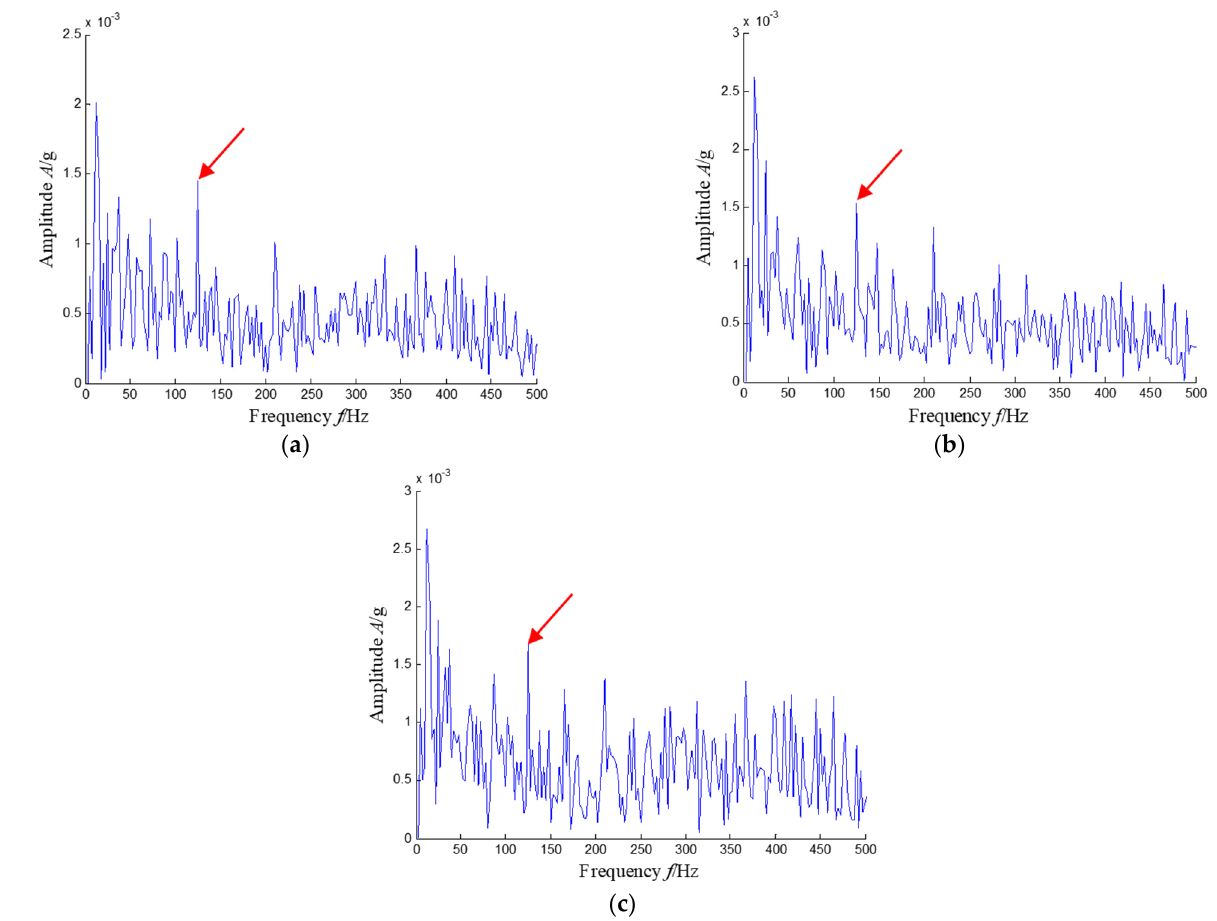
Figure 36. Envelope spectrums of the extracted signal with the other NMF-based methods. ( a ) NMF-based method, ( b ) SNMF-based method and ( c ) KNMF-based method (the fault characteristic f BPFO is highlighted by a red arrow in each method).